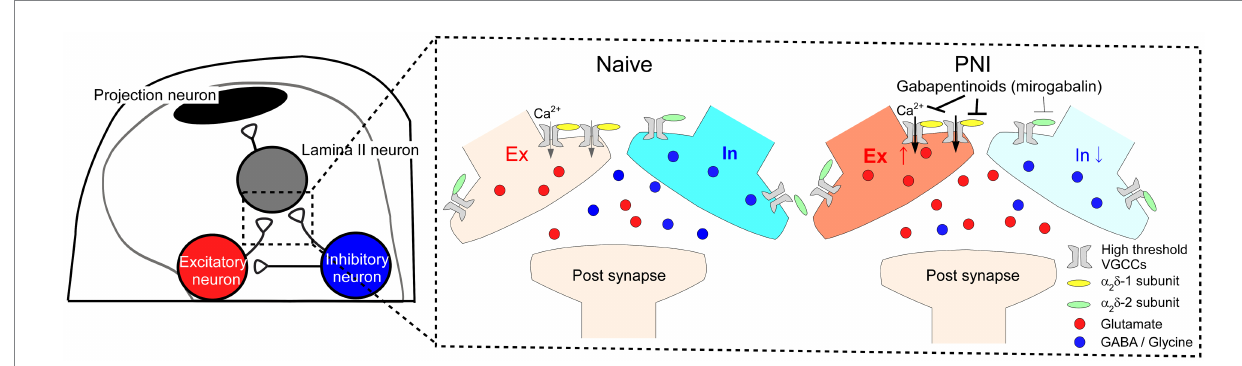
FIGURE 5 Potential mechanisms of disinhibition-induced enhanced excitatory synaptic transmission via α 2 δ -1 expressed in SDH excitatory neurons after PNI and action of gabapentinoids. Schematic of proposed spinal circuitry (left) and mechanisms of the alteration of synaptic transmission after PNI and gabapentinoid action (right) . In PNI mice, excitatory and inhibitory synaptic transmissions are enhanced and attenuated in SDH neurons, respectively. α 2 δ -1 expressed in excitatory SDH neurons could be involved in the enhanced excitatory neurotransmitter release, and gabapentinoids preferentially bind to α 2 δ -1 in excitatory SDH neurons and inhibit the aberrant excitatory synaptic responses and the pain phenotype after